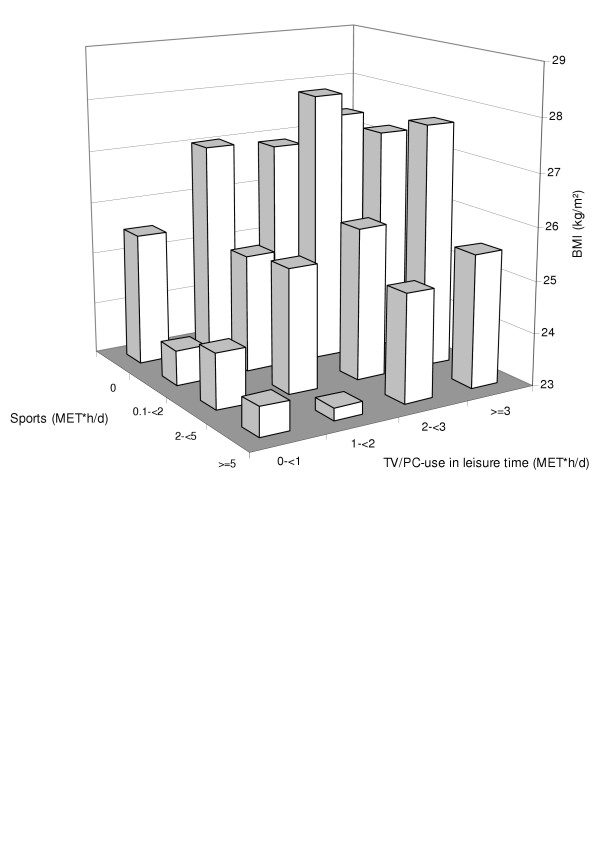
Mean BMI (kg/m2) by sports activity and use of TV/PCleisure time (MET*h/d; n = 893)